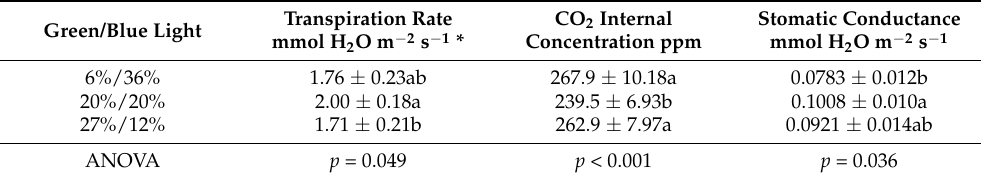
Table 5. Effect of the green (500–600 nm) and blue (400–500 nm) light balance on gas exchange parameters of young mature leaves of strawberry plants grown in an indoor vertical system with LED lighting. Sampling date 26 July 2021.